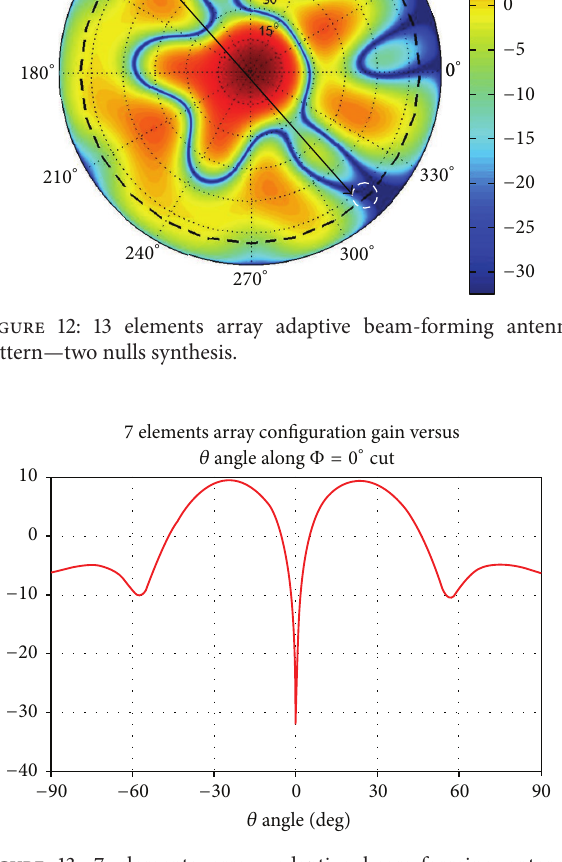
Figure 13: 7 elements array: adaptive beam-forming antenna pattern—single null synthesis.